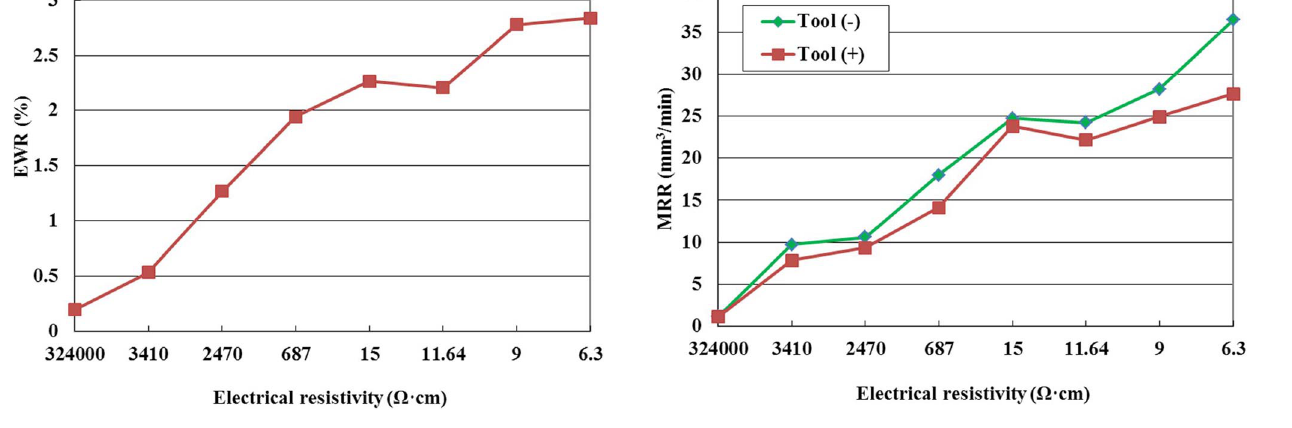
Figure 3. Effect of the electrical resistivity on EWR.